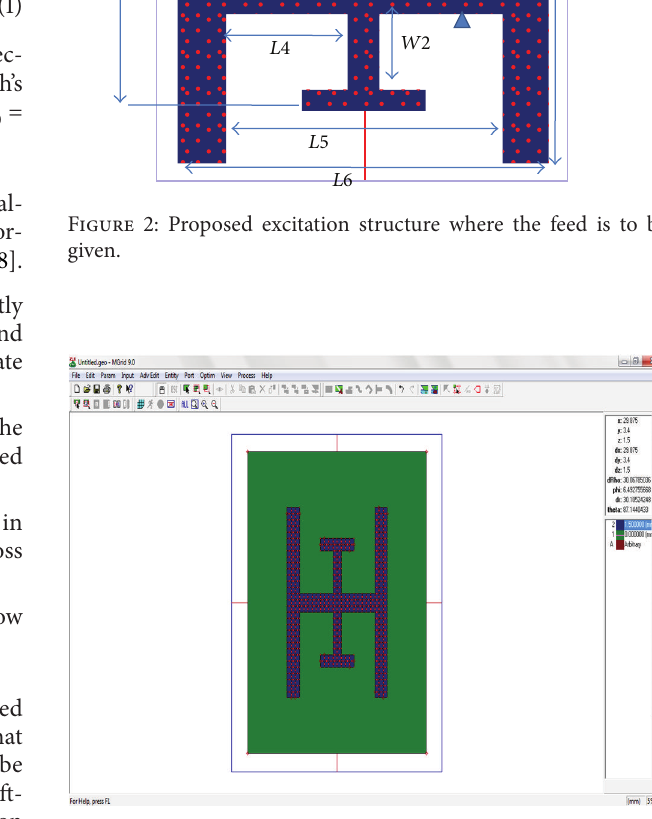
Figure 3: Geometry of proposed antenna with main rectangular reflector.